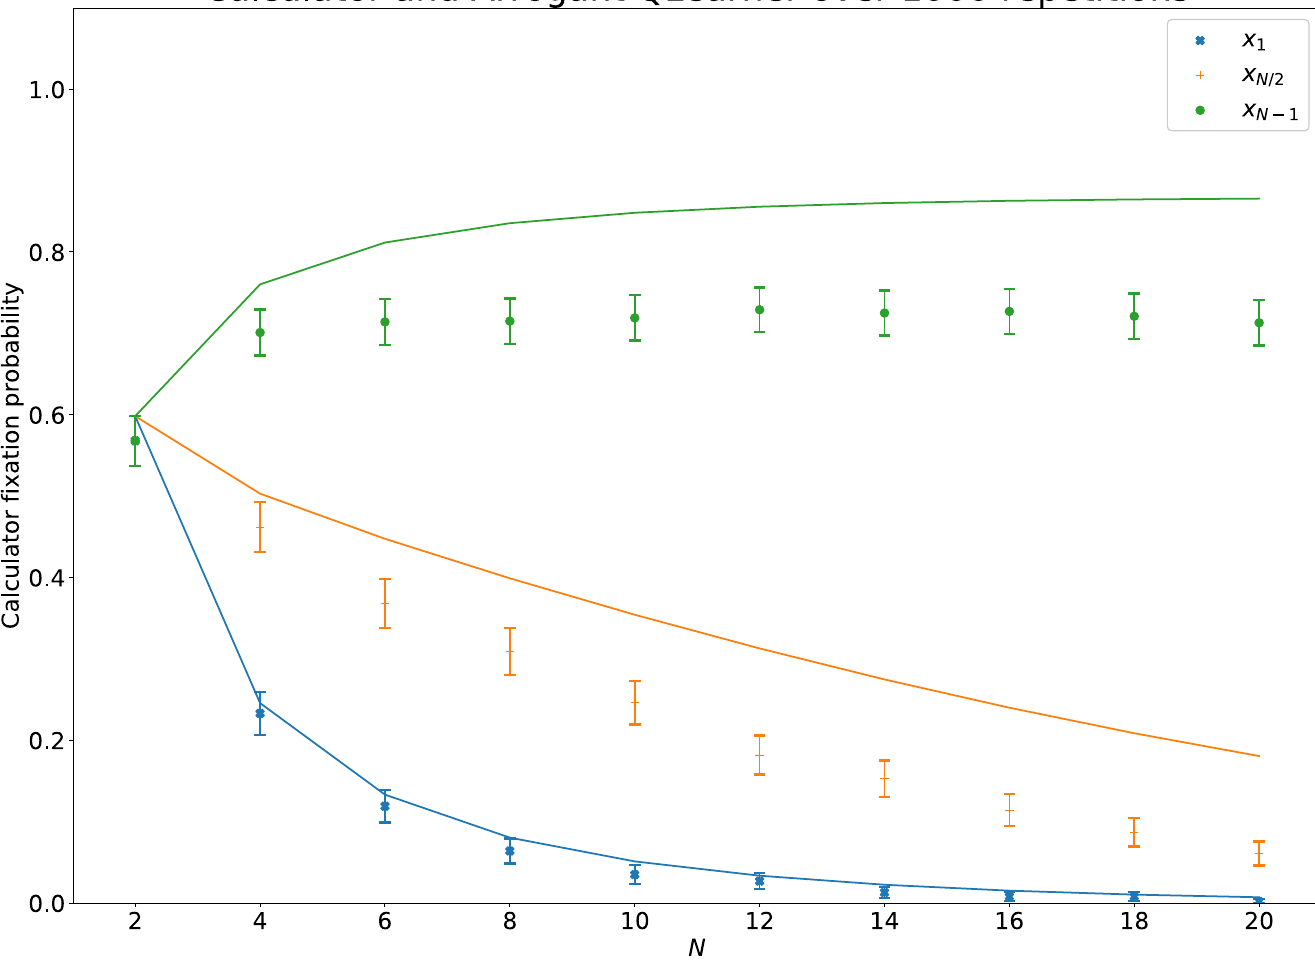
, the middle line (in N − 1